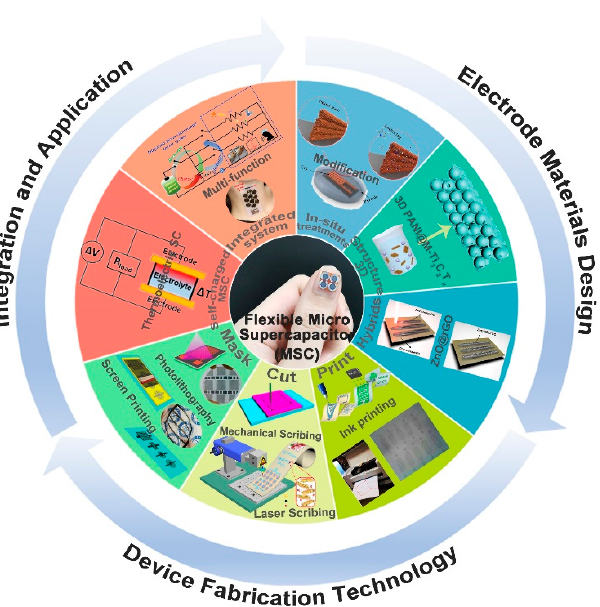
Figure 1. An overview of the flexible on-chip MSCs and their application in smart integrated system. Electrode materials design: Composites—the figure has been reproduced with permission from Springer Nature [56]; 3D architecture—the figure has been reproduced with permission from Wiley [57]; In situ treatment—the figure has been reproduced with permission from Springer Nature [58]; Device fabrication technology: Mask, Photolithography—the figure has been reproduced with permission from The Royal Society of Chemistry [59]; Screen printing—the figure has been reproduced with permission from The Royal Society of Chemistry [60]; Cut, Mechanical scribing—the figure has been reproduced with permission from Wiley [61]; Laser scribing—the figure has been reproduced with permission from Springer Nature [62]; Print, Ink printing—the figure has been reproduced with permission from Springer Nature [63] and Wiley [64]; Integration and application: Self-charged MSC—the figure has been reproduced with permission from Wiley [65]; Integrated system—the figure has been reproduced with permission from Wiley [66].